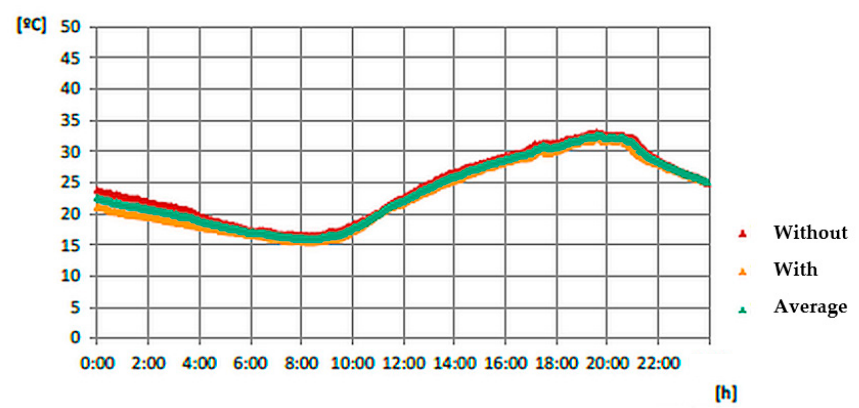
Figure 6. Outside temperature on August 10th and 17th and the average temperature.